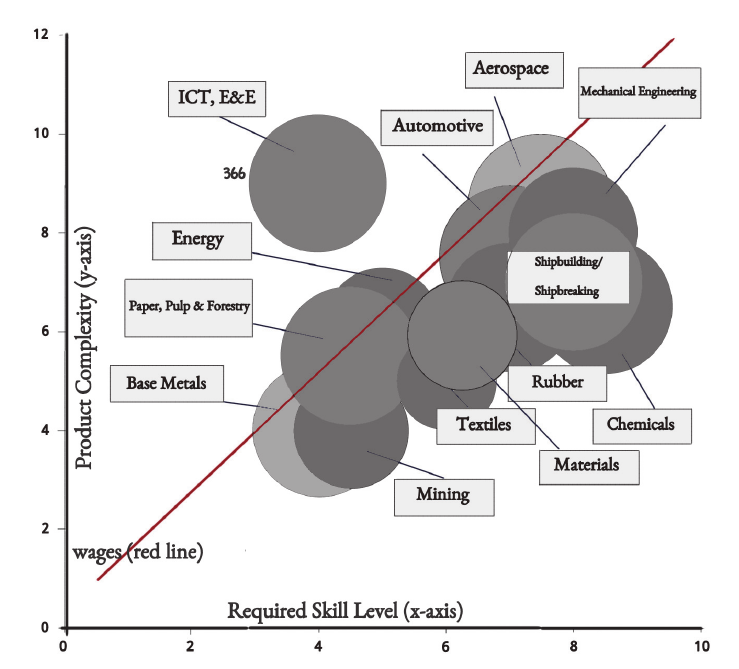
Fig. 2. Qualitative model of IndustriALL’s industrial sectors on a plot of product complexity and required skill level (Source: IndustriALL Global Union, 2017) The background shading corresponds to the regional divide (light grey = developing world, dark grey = developed world; size of bubble indicates relative number of workers affected). Adapted from Hilpert, Y: